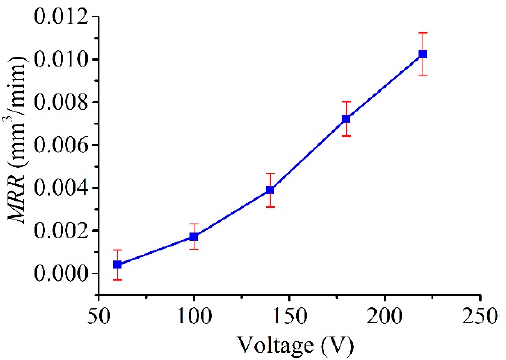
Micromachines 2020 , 11 , x Figure 17. E ff ect of open voltage V s on the MRR. Figure 17. Effect of open voltage V s on the MRR.